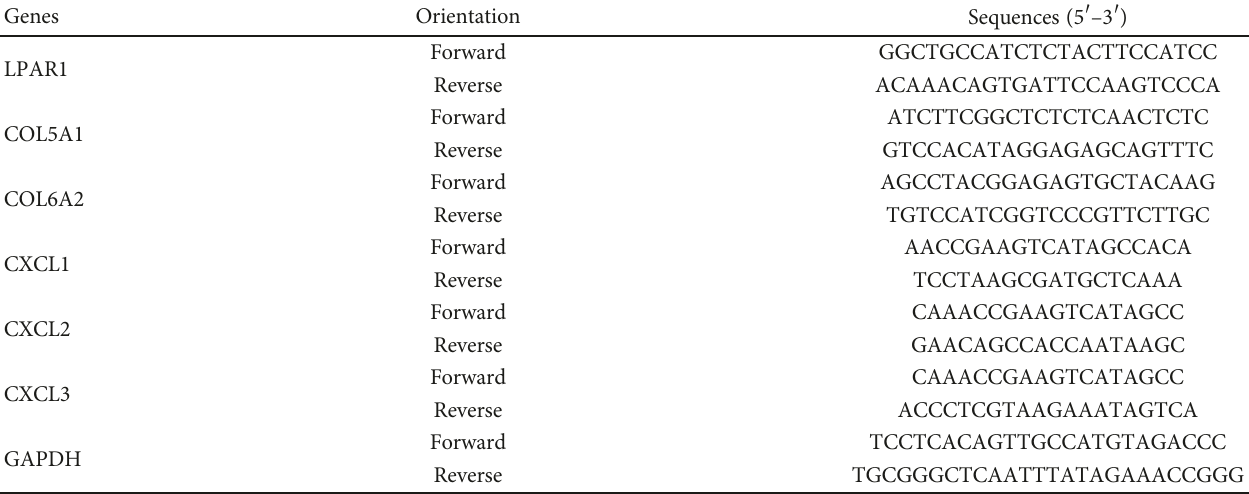
Table 1: The primers for qRT-PCR analysis were applied in this